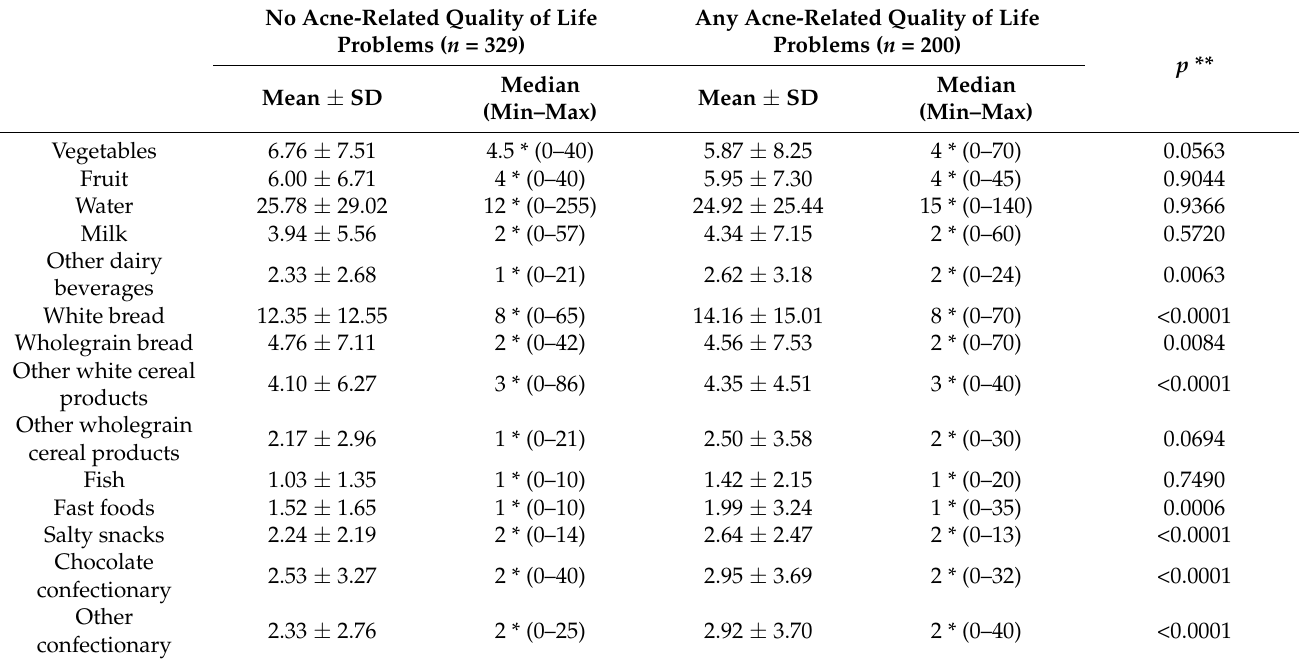
Table 6. Analysis of the difference of dietary intake between male adolescent participants of the study declaring no acne-related quality of life problems and any acne-related quality of life problems within any question of the Acne Quality of Life (AQoL) scale.